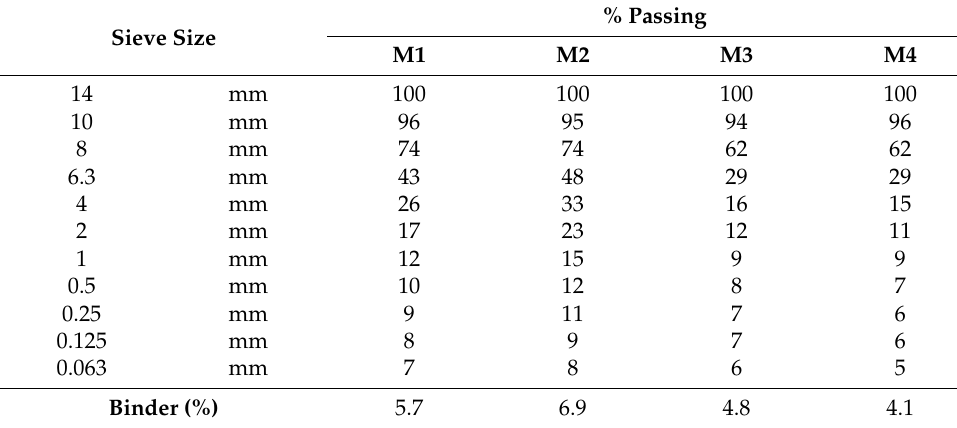
Table 5. Compositional analysis of plant-produced asphalt.